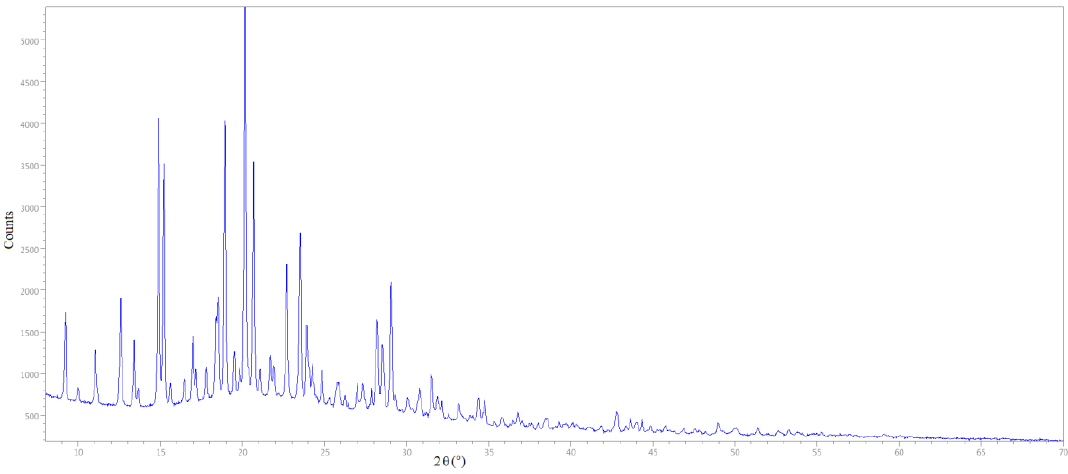
ff raction pattern of C 13 H 17 N 3 O 2